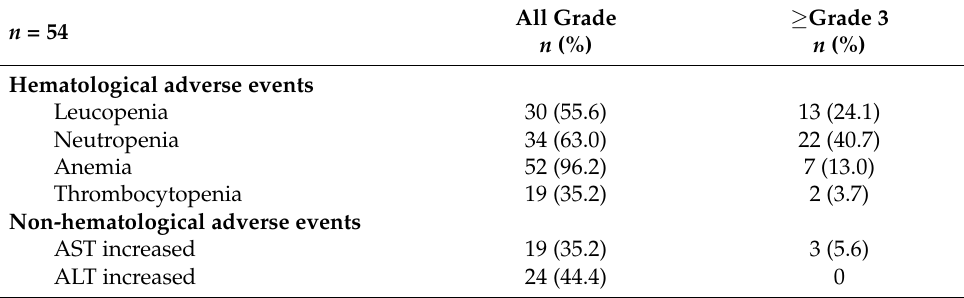
Table 3. Adverse events for all